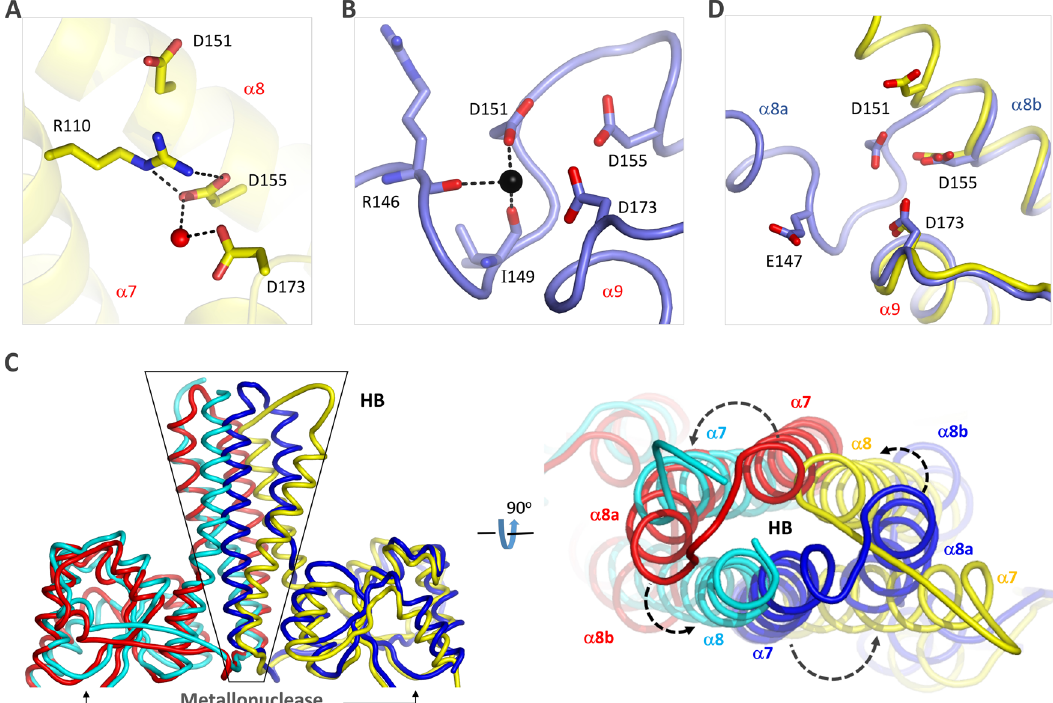
Fig. 3 Conformational change of Pb HARP. A Conformation of the Asp residues observed in the apo-form Pb HARP structure. B Conformation and cation coordination of the Asp residues observed in the pre-tRNA-complexed structure. Ca 2 + ion is shown as black sphere, the Ca 2 + -coordinating residues are shown as sticks. C , D Structural superposition showing the conformational changes of Pb HARP. The apo-form structure is colored in yellow and cyan, whereas the pre-tRNA-complexed structure is colored in blue and